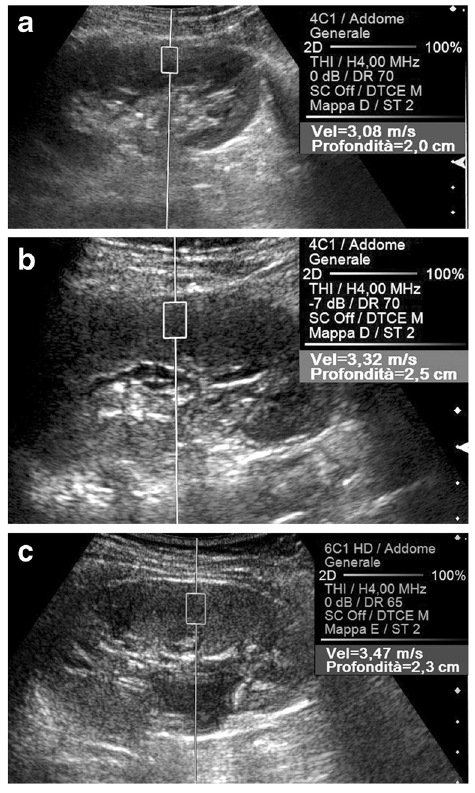
Fig. 12 ARFI evaluation of kidney. Oblique US scans on the left kidney ofthreedifferent 12-year-oldboys. The corticalSWV value islower (3.08 vs. 3.47 m/s) in a healthy control ( a ) than in a boy with chronic kidney disease due to vesicoureteral reflux ( c ) treated at younger age. Intermediate SWV values (3.32 m/s) are measured in the apparently normal left kidney ( b ) of a boy with chronic contralateral disease